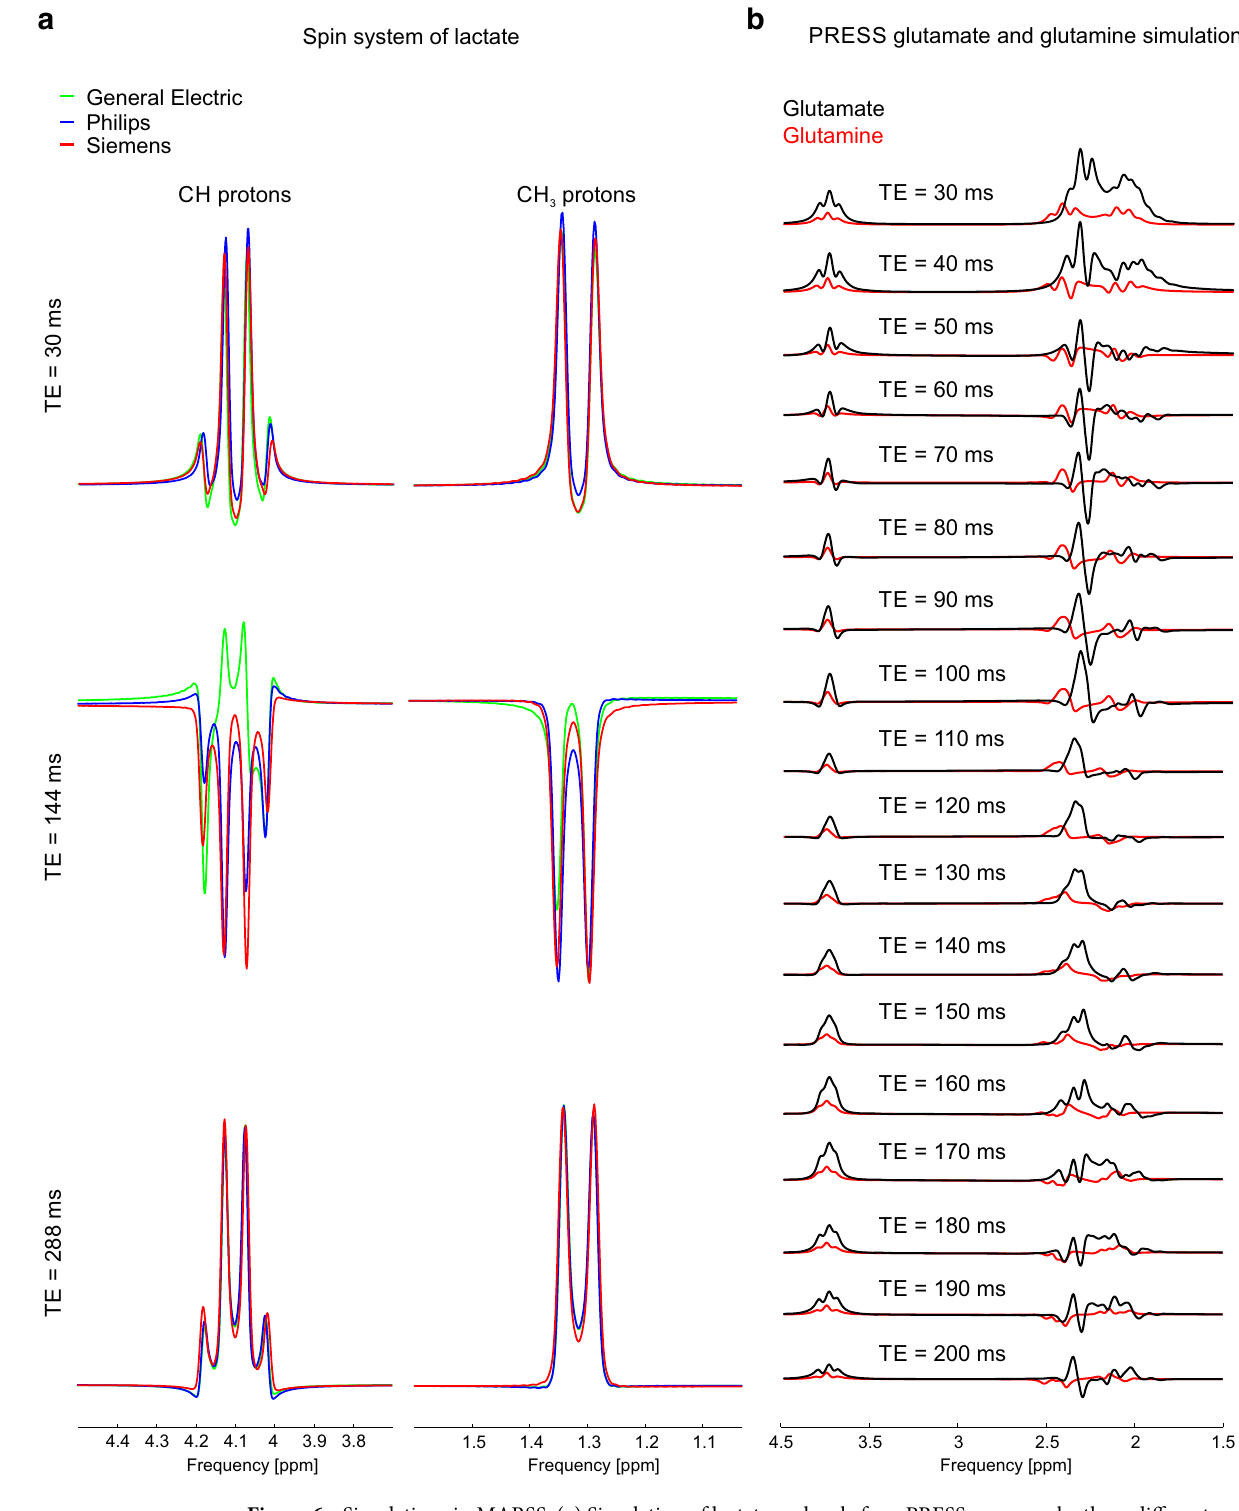
Figure 6. Simulations in MARSS. ( a ) Simulation of lactate molecule for a PRESS sequence by three different vendors and three different echo times for 3 T. Spectra were line broadened with a 1-Hz Gaussian filter. Note that the amplitudes of CH and CH 3 protons are scaled for display purposes. ( b ) Simulation of glutamate (10.2 mM) and glutamine (2.5 mM) molecules for the realization of the PRESS sequence by Siemens at 3 T over a wide range of echo times. Spectra were line broadened with a 5-Hz Lorentzian